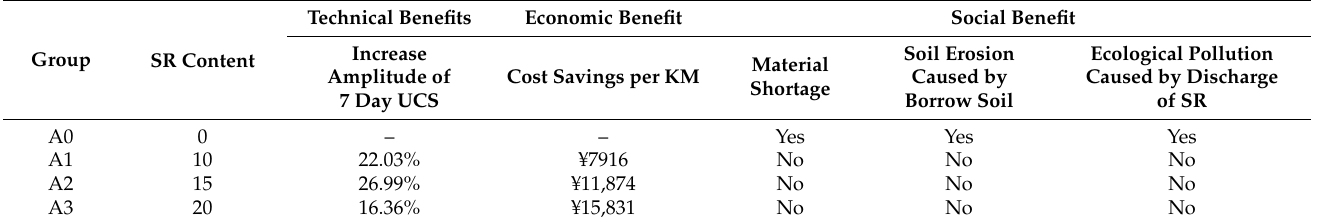
Table 6. Benefit